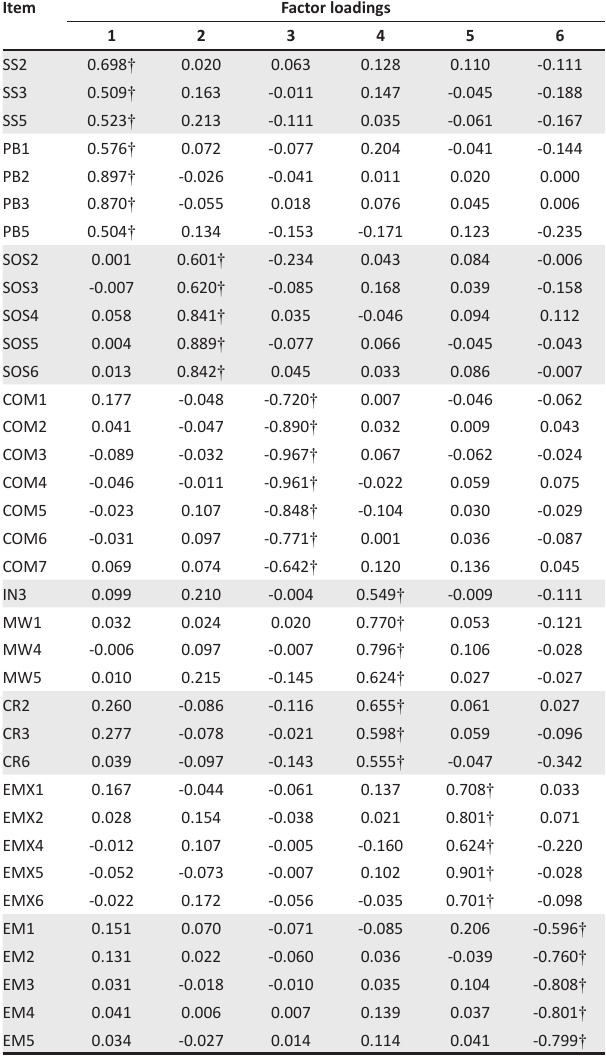
TABLE 2: Final factors and factor loadings after the fourth extraction.